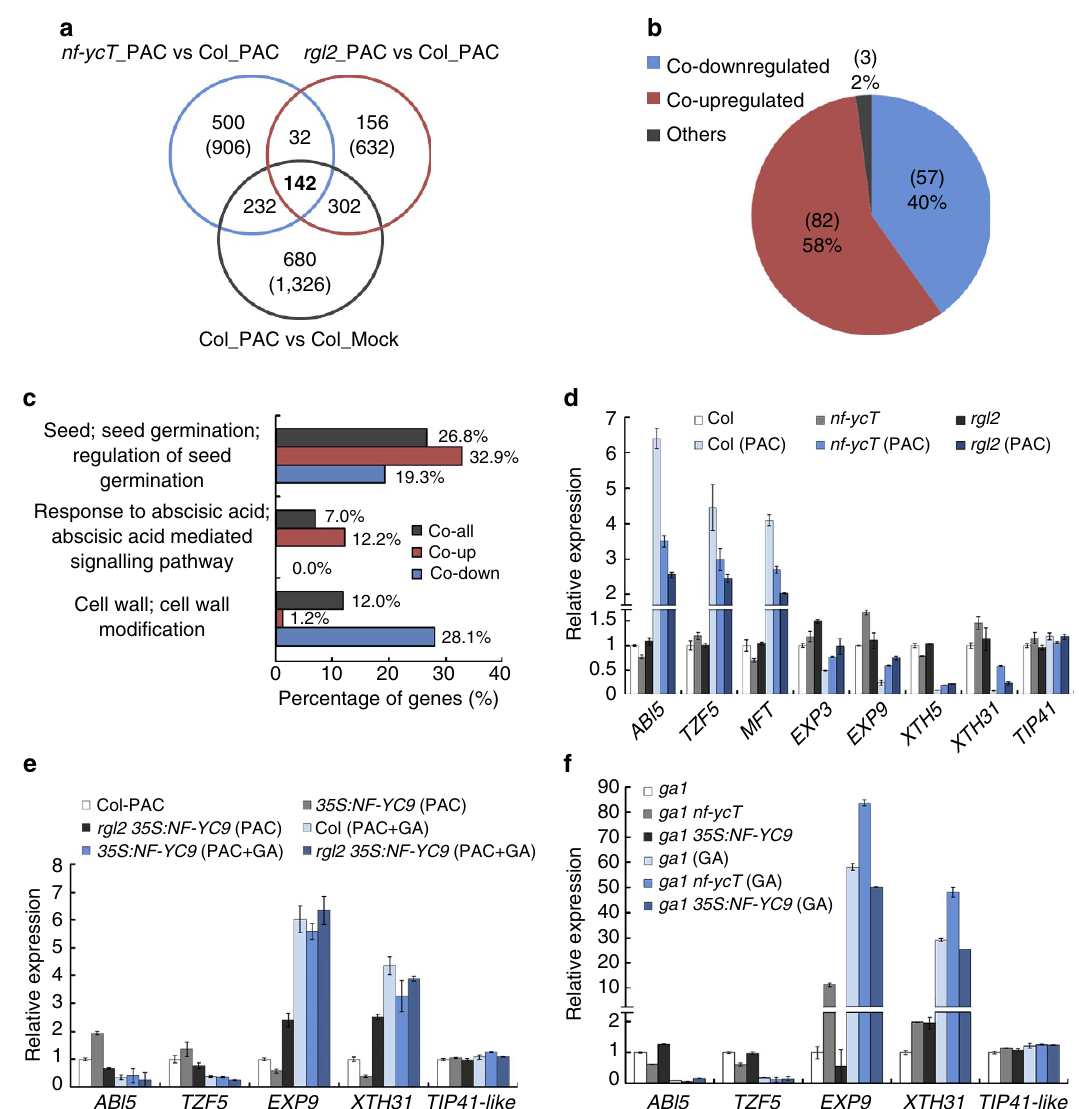
Figure 4 | Transcriptomic analysis of regulatory gene expression profiles by NF-YCs and RGL2 in response to GA. ( a ) The Venn diagram shows the coregulated genes by GA, NF-YCs and RGL2, indicated as the overlap among the differentially expressed genes in nf-ycT _PAC versus Col_PAC, rgl2 _PAC versus Col_PAC, and Col_PAC versus Col_Mock. ( b ) Percentages of the co-upregulated, the co-downregulated and the genes in the other patterns by GA, NF-YCs and RGL2. Values enclosed in parentheses indicate the numbers of genes. ( c ) Gene ontology analysis of the coregulated (co-all), the co- upregulated (co-up) and the co-downregulated (co-down) genes by GA, NF-YCs and RGL2. Numbers indicate the percentages of genes included in each GO category. ( d ) Quantitative RT–PCR analysis of the expression level of several selected cell wall-related and ABA responsive genes coregulated by GA, NF-YCs and RGL2. The wild-type (Col), rgl2 and nf-ycT seeds were grown on 1/2 MS medium containing 5 m M PAC or not for 12 HAS. The relative gene expression was normalized to that of PP2A internal control and then calculated by comparing the value with that in Col. TIP41-like gene was used as a negative experimental control. Data represent mean ± s.d. of three biological replicates. ( e ) Quantitative RT–PCR analysis of the expression level of the selected coregulated genes in Col, 35S:NF-YC9 and rgl2 35S:NF-YC9 seeds grown on 1/2 MS medium containing 5 m M PAC or 5 m M PAC plus 1 m M GA for 12 HAS. The relative gene expression was normalized to that of PP2A internal control and then calculated by comparing the value with that in Col with PAC treatment (Col-PAC). Data represent mean ± s.d. of three biological replicates. ( f ) Quantitative RT–PCR analysis of the expression level of the selected coregulated genes in ga1 , ga1 nf-ycT and ga1 35S:NF-YC9 seeds grown on 1/2 MS medium containing 1 m M GA or not for 12 HAS. The relative gene expression was normalized to that of PP2A internal control and then calculated by comparing the value to that in ga1 . Data represent mean ± s.d. of three biological